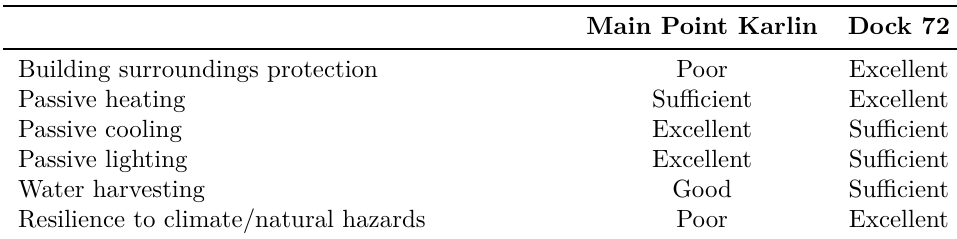
Table 4. Qualitative assessment for resilient